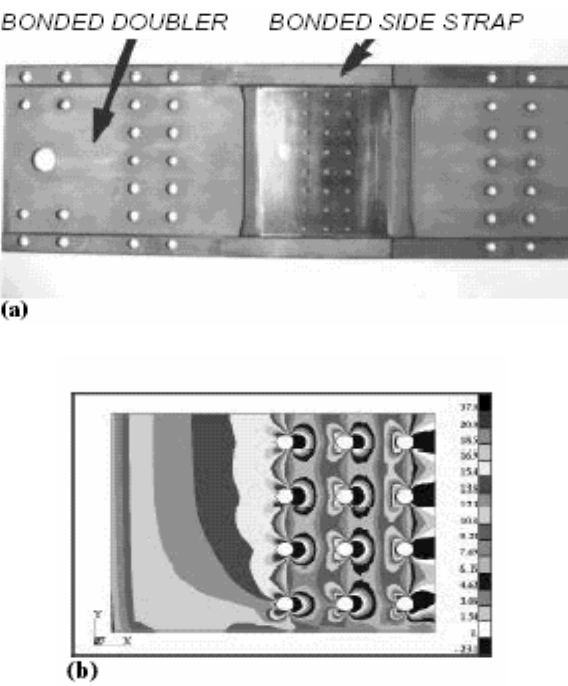
Fig 2. Illustration of MSD specimen (a) bonded doublers, (b) with a hoop stress distribution at faying surface by finite element